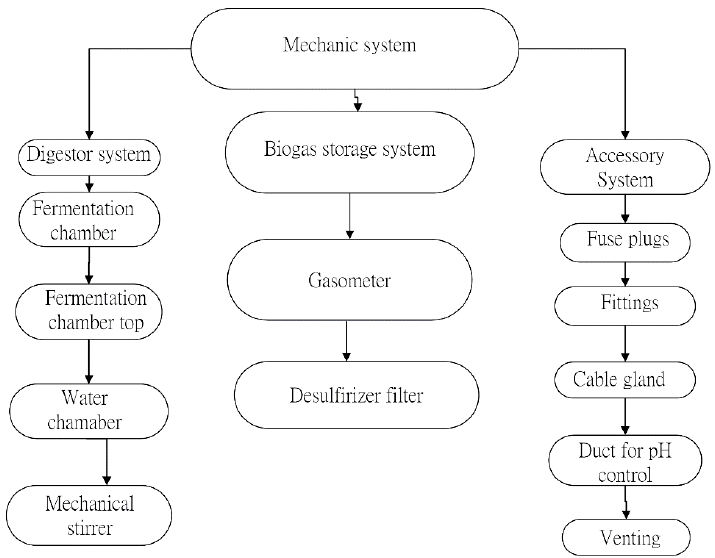
Figure A1. Elements of the mechanical system [9].